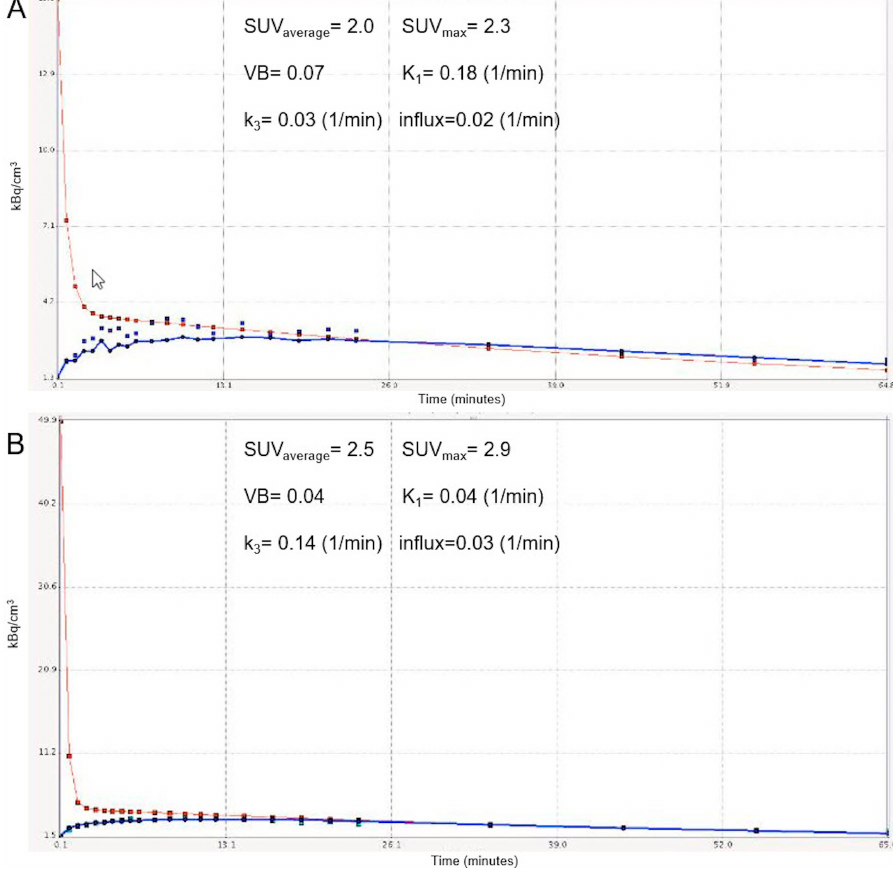
Figure 5. Time-activity curves (TACs) derived from dynamic positron emission tomography/computed tomography (PET/CT) studies of a retroperitoneal soft tissue sarcoma (STS) before ( A ) and after ( B